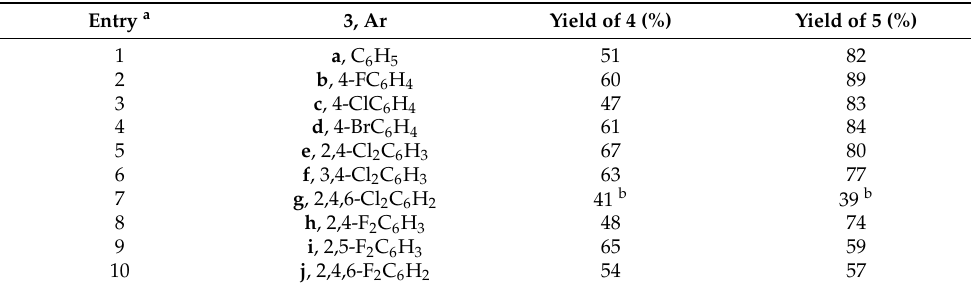
Table 3. Synthesis of compounds 4 and 5 in NaHCO 3 –MeCN